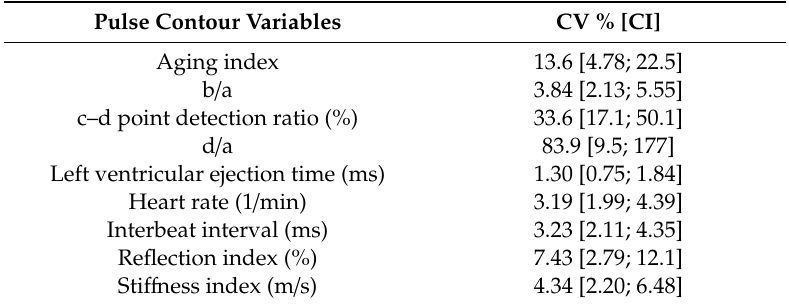
Table 2. Results of test–retest variability measurements. Test–retest variability of pulse contour parameters measured by the SCN4ALL telemedicine system. Measurements were performed on 10 healthy volunteers 10 times repeatedly under standardized conditions. Coe ffi cient of variation (CV) for the results of the consecutive measurements was calculated for each individual. Afterwards individual CVs were averaged; they are presented in the table along with bracketed confidence intervals